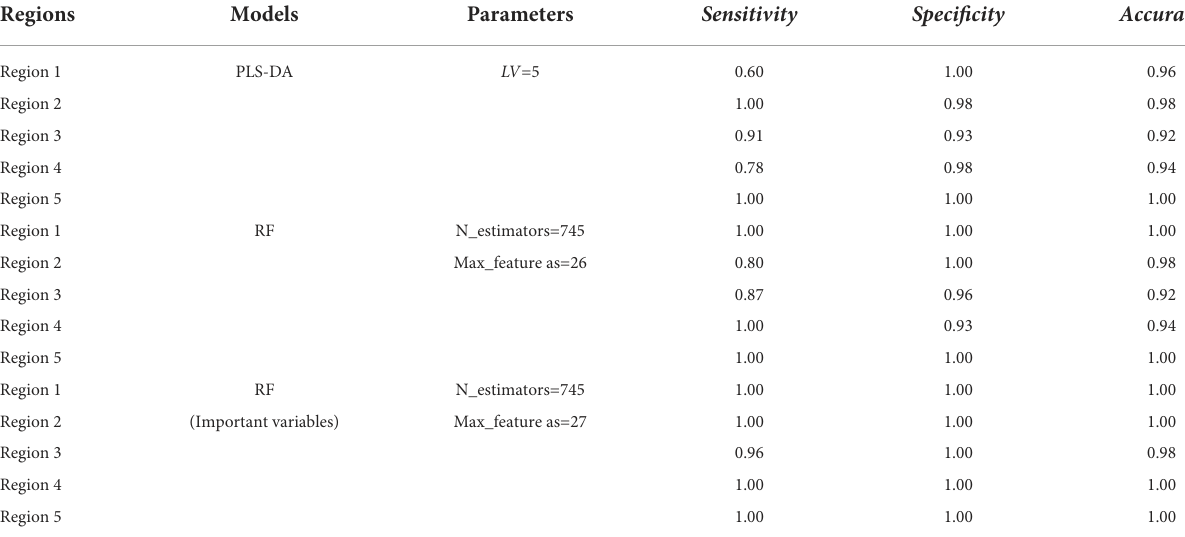
TABLE 4 The performance of chemometric models for the region discrimination based on NIR spectra. Regions Models Parameters Sensitivity Specificity Accuracy